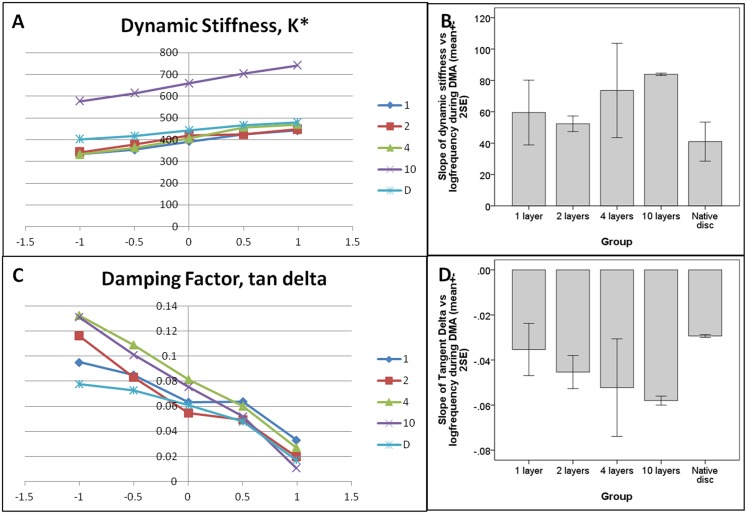
Dynamic stiffness and damping factor of samples during the dynamic mechanical analysis (DMA).(A) Line chart of the dynamic stiffness against the log loading frequency. (B) Bar chart showing the slope values measured for the dynamic stiffness-log loading frequency curves (mean+-2SE, n = 2–4). (C) Line charts of the damping factor (tangent delta) against log loading frequency; D: Bar chart showing the slopes of the tangent delta-log loading frequency curves (mean+-2SE, n = 2–4).